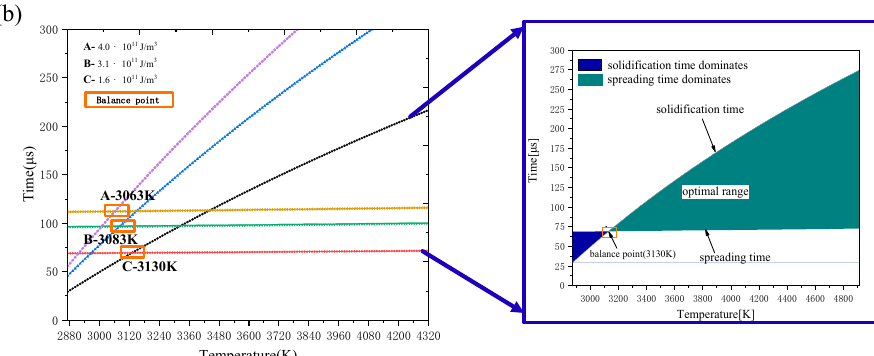
Figure 10. The relationship between laser interaction time and spread-solidification mechanism. ( a ) Laser residence time required to reach evaporation point and melting point at different energy densities. ( b ) Solidification time and spreading time calculated with three energy densities.